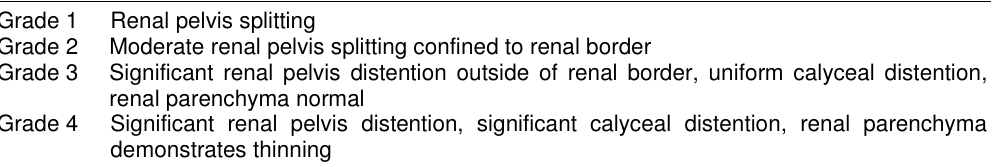
FIGURE 3. SFU grading system for